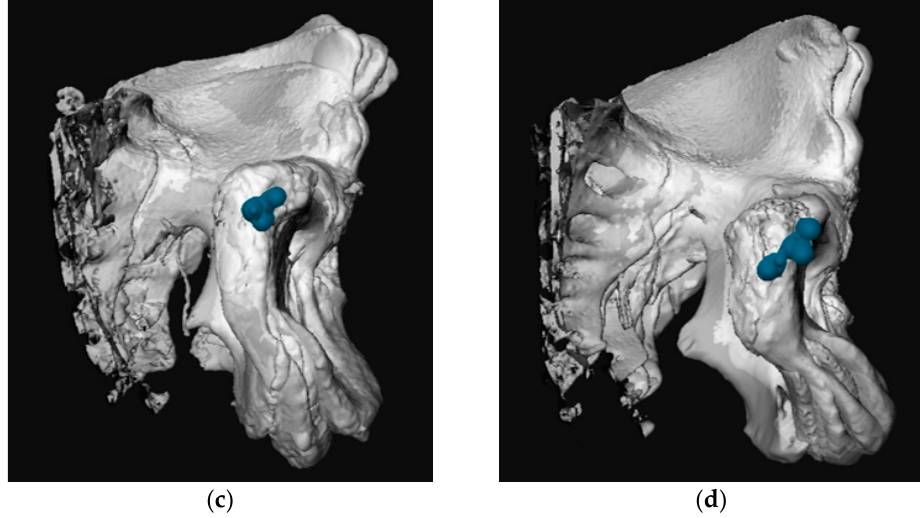
Figure 4. Superimposed three-dimensional (3D) pelvic models including the most optimal screw per case (blue). Analyzing males and females separately resulted in a more compact entry zone. ( a ): sagittal view females; ( b ) sagittal view males; ( c ) frontal view females; ( d ) frontal view males.